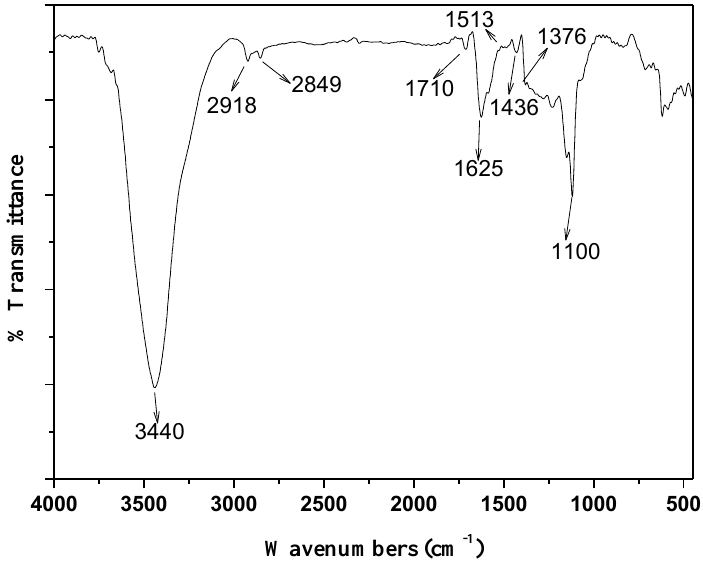
Figure 3. FTIR spectra of the samples: ( a ) raw C